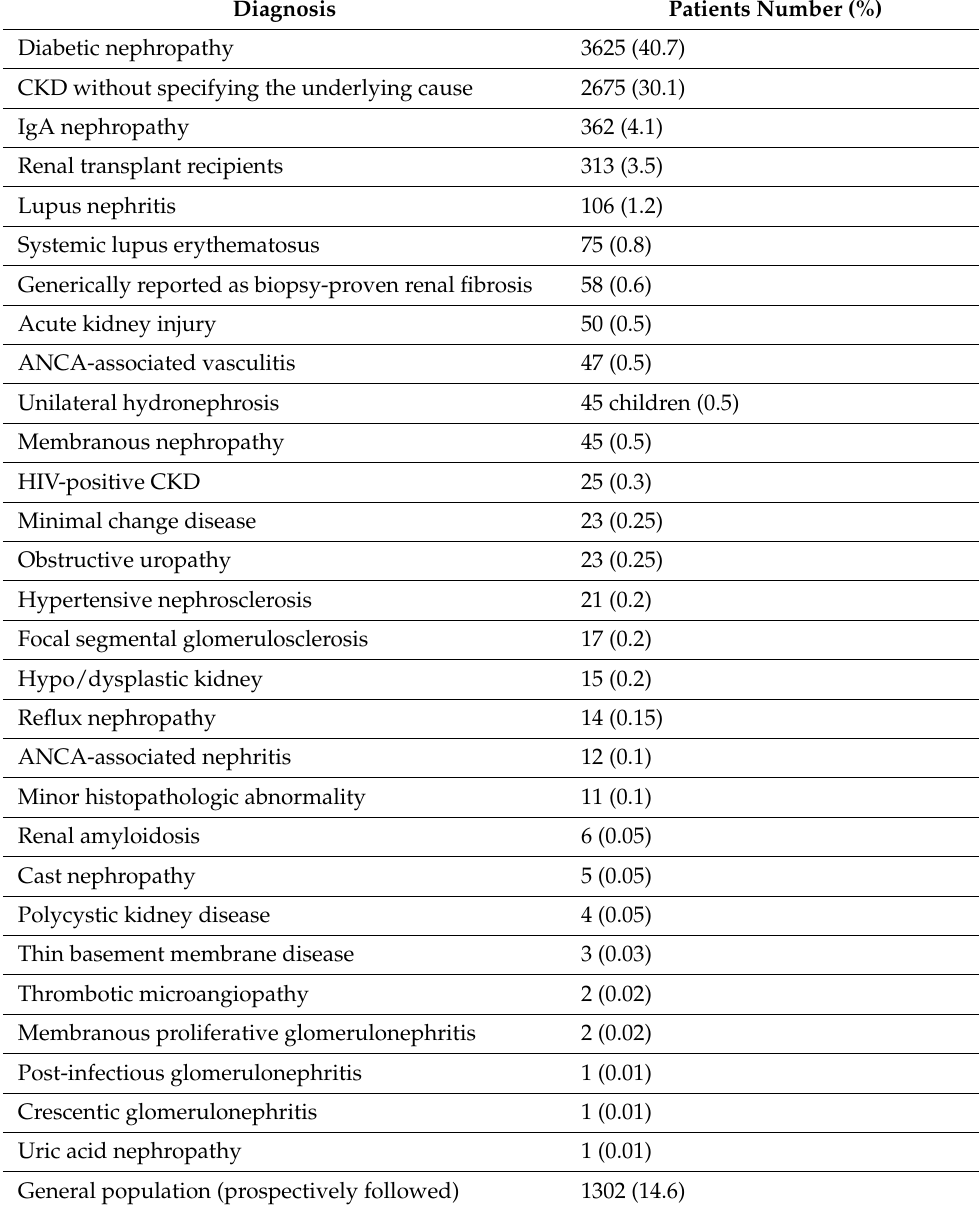
Table 2. Summary of patients’ diagnosis regarding the whole cohort included in the